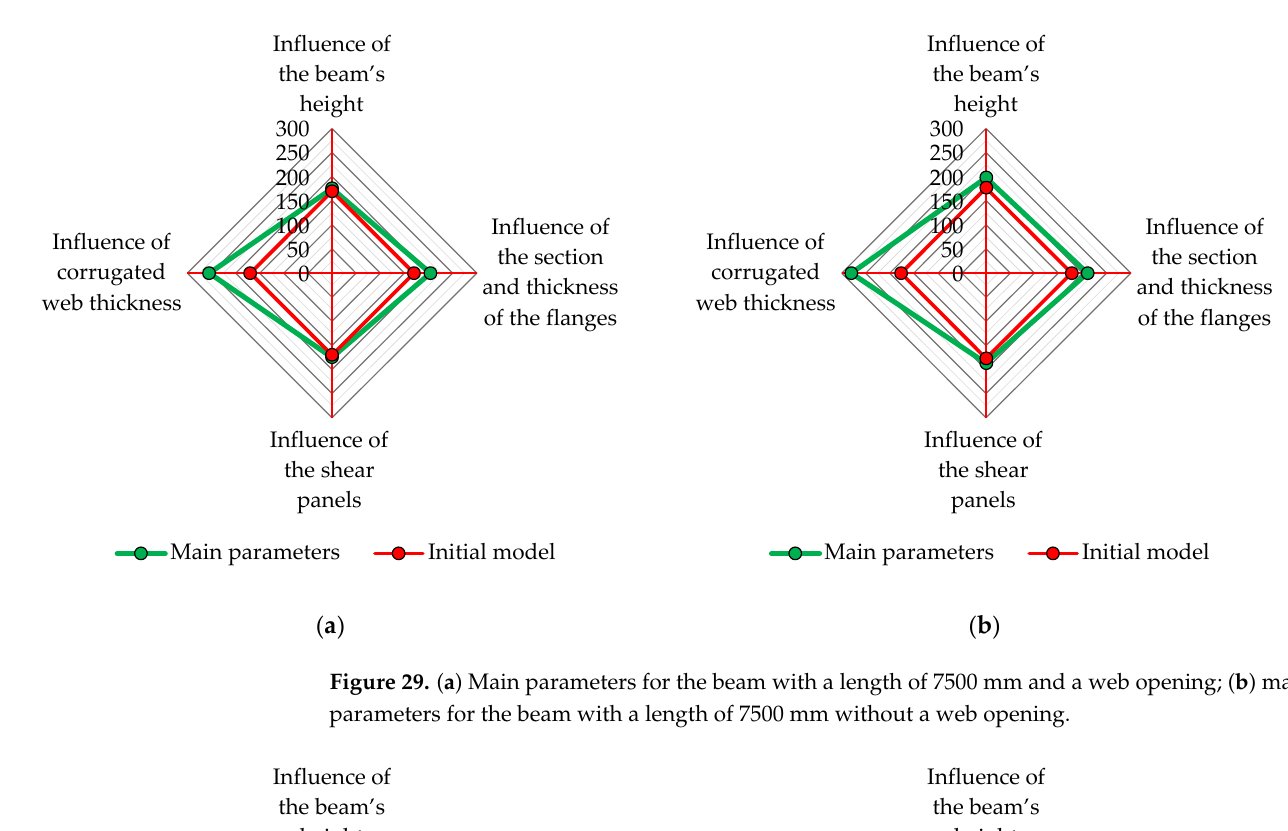
Figure 28. ( a ) Main parameters for the beam with a length of 6000 mm and a web opening; ( b ) main parameters for the beam with a length of 6000 mm without a web opening.